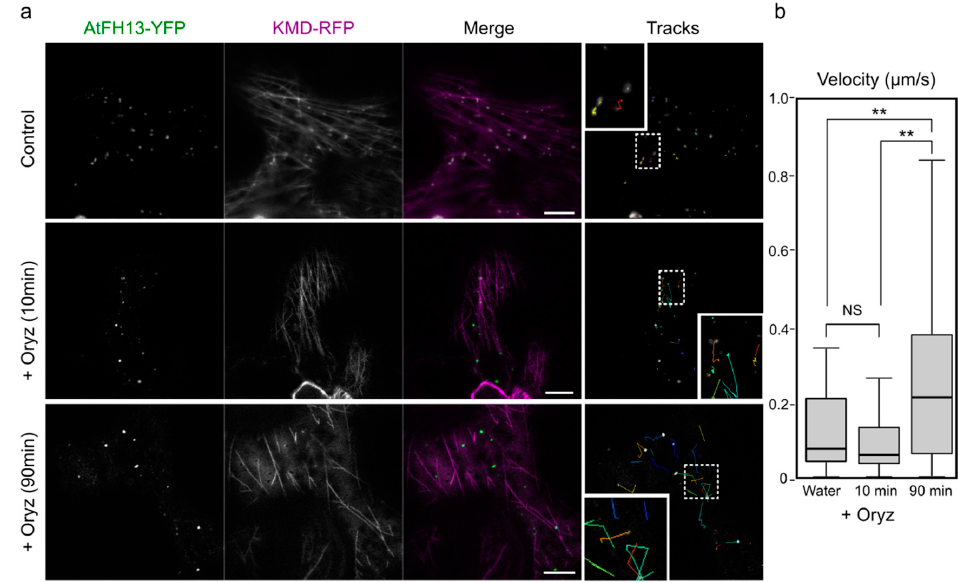
Figure 5. Prolonged oryzalin treatment increases mobility of AtFH13-YFP dots. ( a ) Epidermal cells co-expressing AtFH13-YFP and KMD-RFP mock-treated with water (control) and after 10 µM oryzalin treatment (+Oryz) for 10 min (no microtubule disruption observed) or 90 min (microtubules largely depolymerized). Single channel images are shown in grayscale, merged images display an overlay of the YFP channel in green with RFP in magenta. Particle tracks show trajectories of individual AtFH13-YFP dots over 50 s with insets magnified 2.5 times compared to the main image. ( b ) Box plot of mean velocities of AtFH13-YFP particles without, after 10 and after 90 min of oryzalin treatment. Scale bar is 10 µ m. Two asterisks indicate a statistically significant di ff erence (ANOVA, p < 0.001), NS: Non-significant. Construct abbreviations are defined in the text and in Figure